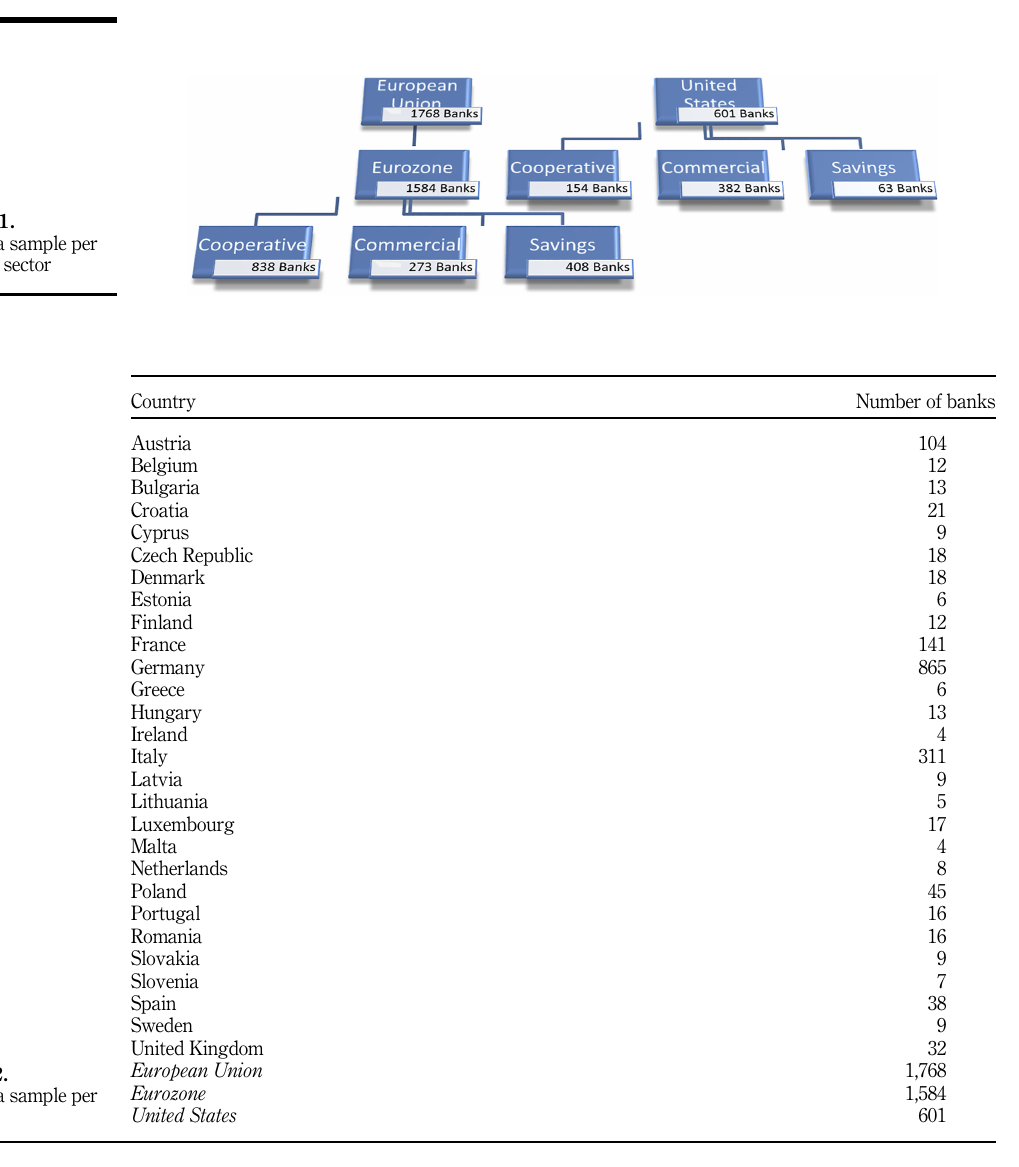
Table 2. The data sample per